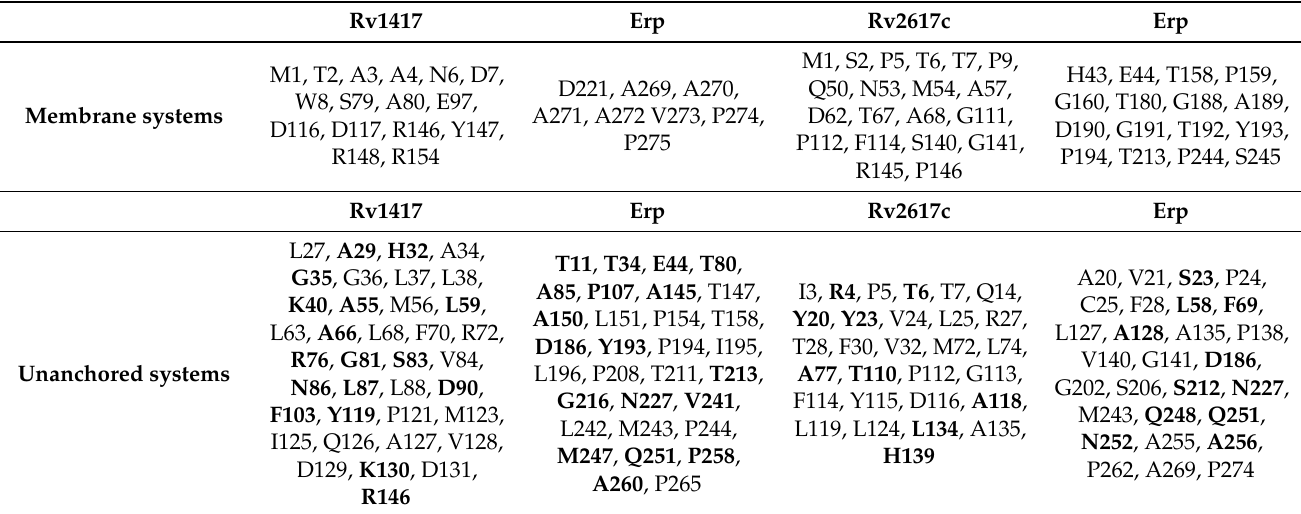
Table 3. Main contact residues in heterodimer